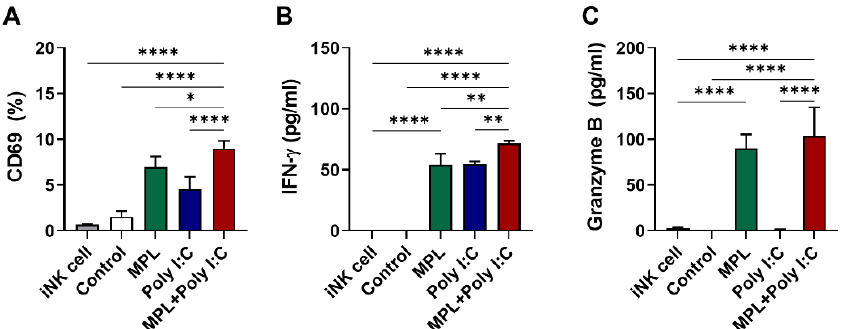
Figure 6. In vitro activation of immature NK cell from naïve mice by adjuvant pre-treated matured DCs. BMDCs were pre-activated by MPL, poly I:C, or MPL + poly I:C for two days, and then co-cultured with NK cell isolated from spleen cells of naïve C57BL/6 mice for two days. CD69 NK activation marker expressions were analyzed by flow cytometry ( A ), and IFN-γ ( B ) and Granzyme B ( C ) levels in culture supernatant were determined by ELISA. The data show the mean ± SD. Statistical analysis between groups were performed by one-way ANOVA and Tukey’s multiple comparison test. *; p < 0.0332, **; p < 0.0021, and ****; p < 0.0001.